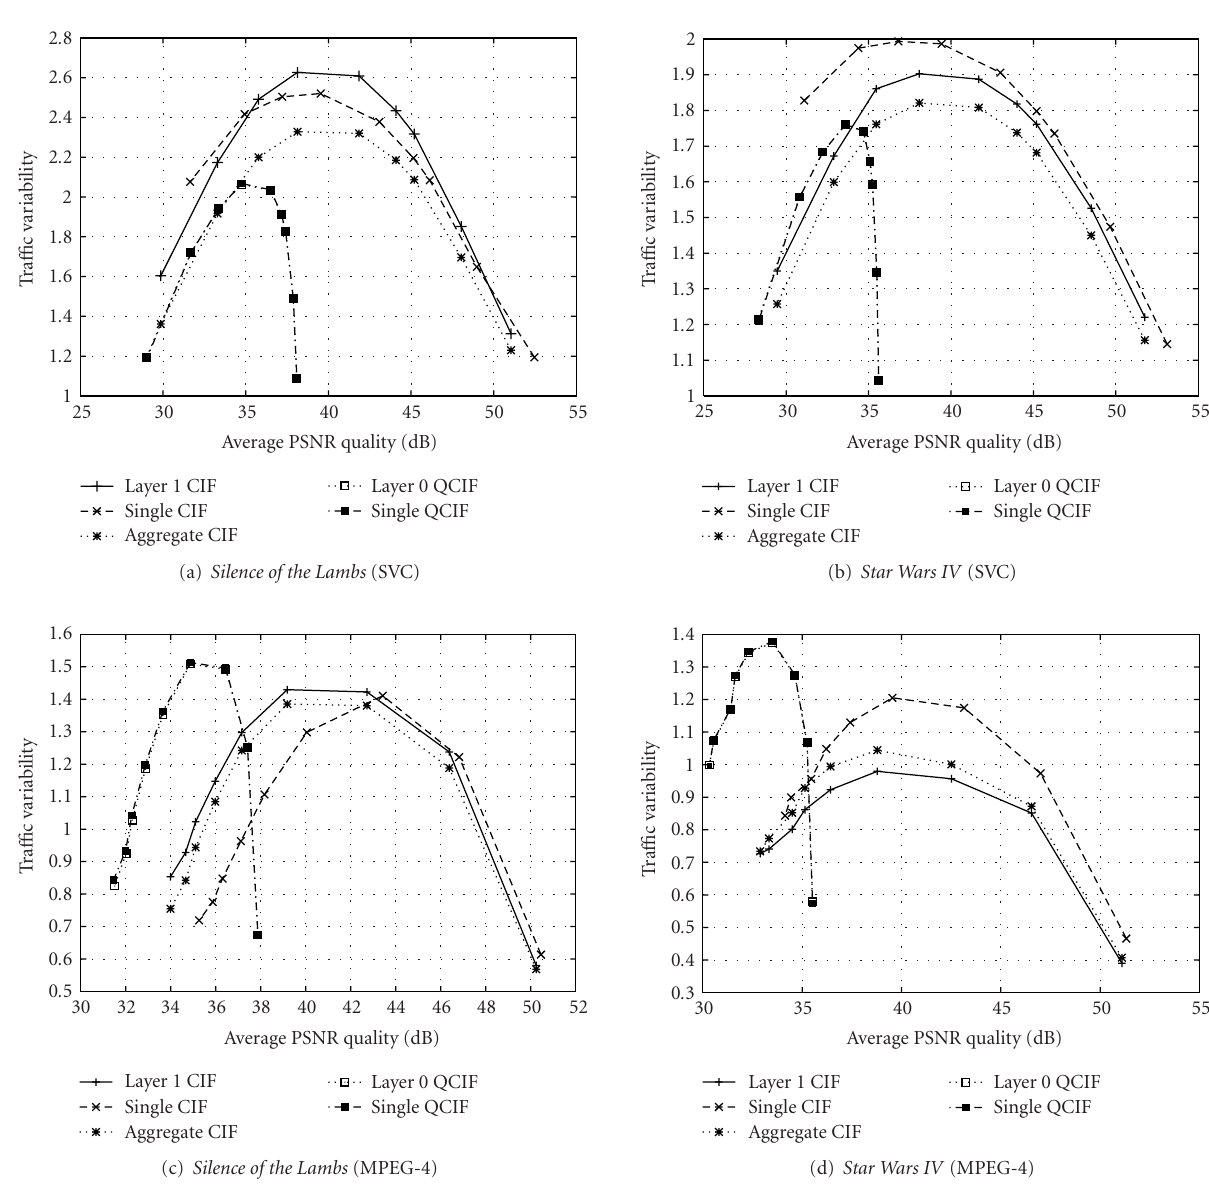
Figure 6: VD curves of two spatial layers ( 0 = QCIF , 1 = CIF ), the aggregated tra ffi c ( aggr ), and single-layer tra ffi c ( single ), for the Silence of the Lambs and Star Wars IV sequences ( G16-B3 GoP